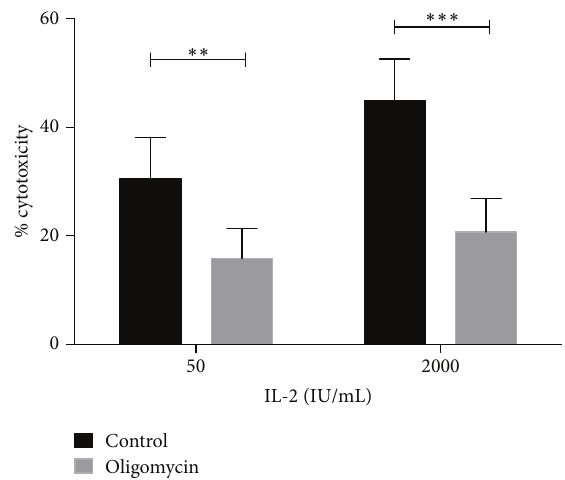
Figure 4: Inhibition of ATP synthase with oligomycin decreased cytotoxicity in NK cells and IL-2-activated NK cells. Human NK cells were incubated in culture for 72 h in the presence of 50 IU/mL (control) or 2000 IU/mL to induce LAK activity. When indicated, cells were pretreated with 5 𝜇 M oligomycin for 30min. Cytotoxic activity was measured in a 4h 51 Cr release assay using Daudi cells as target cells and a 1:1 effector :target ratio. Results are mean ± SE from at least 7 independent experiments ( ∗∗ 𝑝 < 0.01 ; ∗∗∗ 𝑝 < 0.001 ).